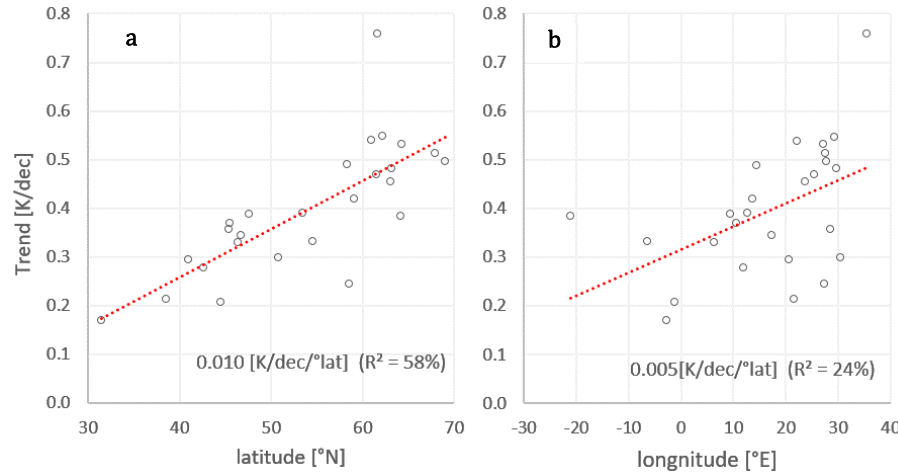
Figure 10. South–north gradient ( a ) and the west–east gradient ( b ) of the yearly LSWT trend. The red dashed line is a simple linear model derived with least square regression, and R2 is the coefficient of determination.